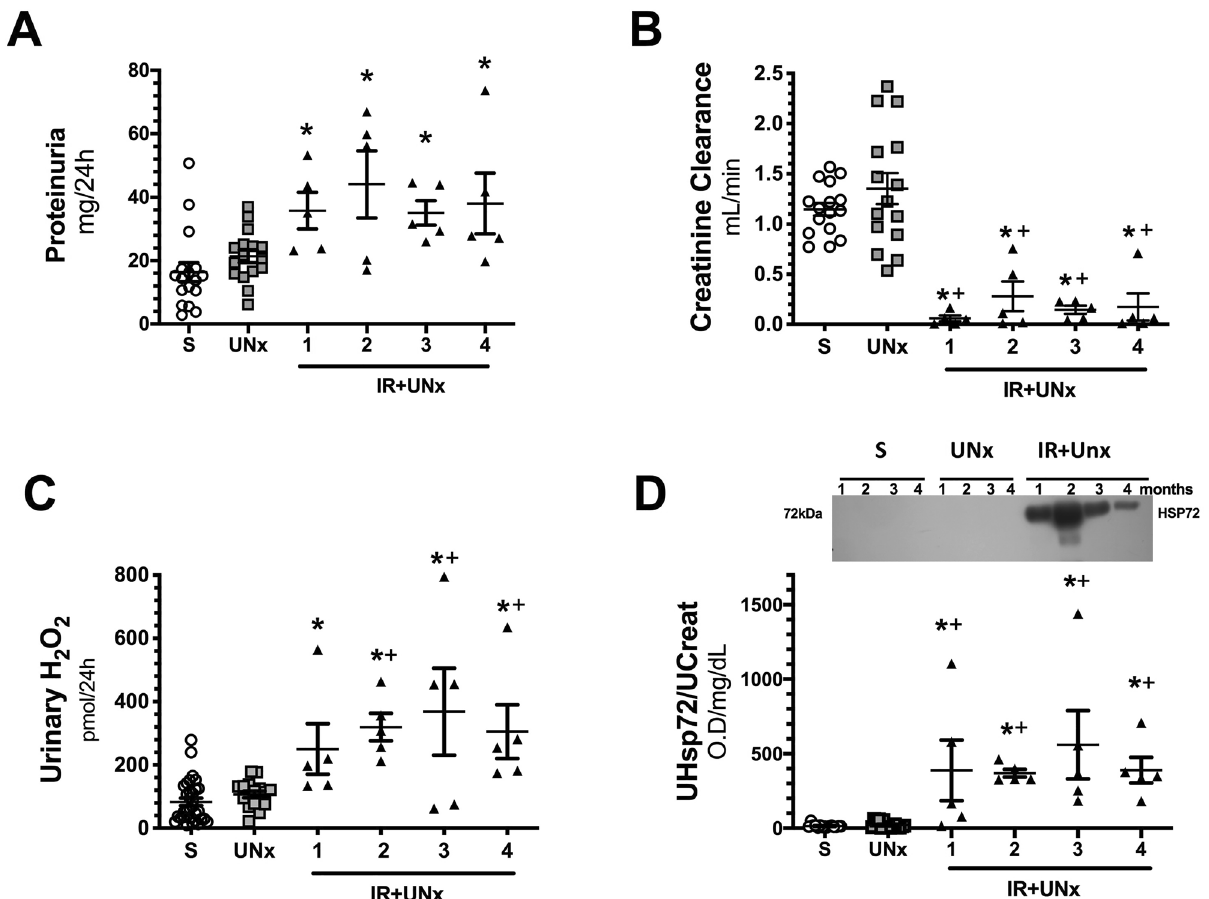
Figure 1. Renal injury induced by unilateral ischemia after 24 h of reperfusion. ( A ) Proteinuria, ( B ) Creatinine clearance, ( C ) Urinary hydrogen peroxide, and ( D ) Urinary HSP72 corrected by urinary creatinine, including a representative cropped blot image. Data are represented as the mean ± SE (for S, n = 16, for UNx, n = 16 and n = 20 for IR + UNx groups). White bars represent the S, gray bars represent UNx, and black bars represent IR + UNx groups. The one-way analysis of variance (ANOVA) was used to determine statistical differences, using the Bonferroni correction for multiple comparisons. * p < 0.05 versus S group and + p < 0.05 versus UNx group. Full-length blots are presented in Supplementary Fig.